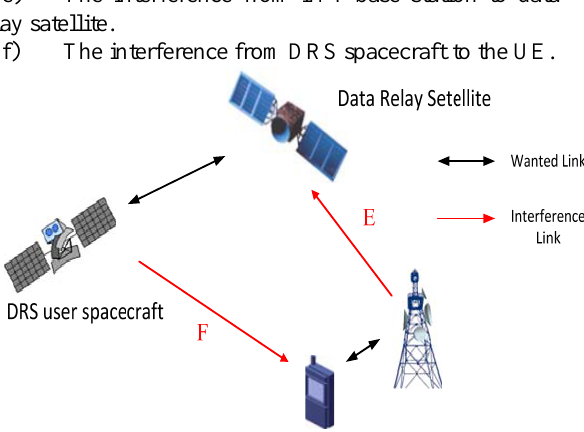
Fig. 2. Sharing scenario between IMT-base station and